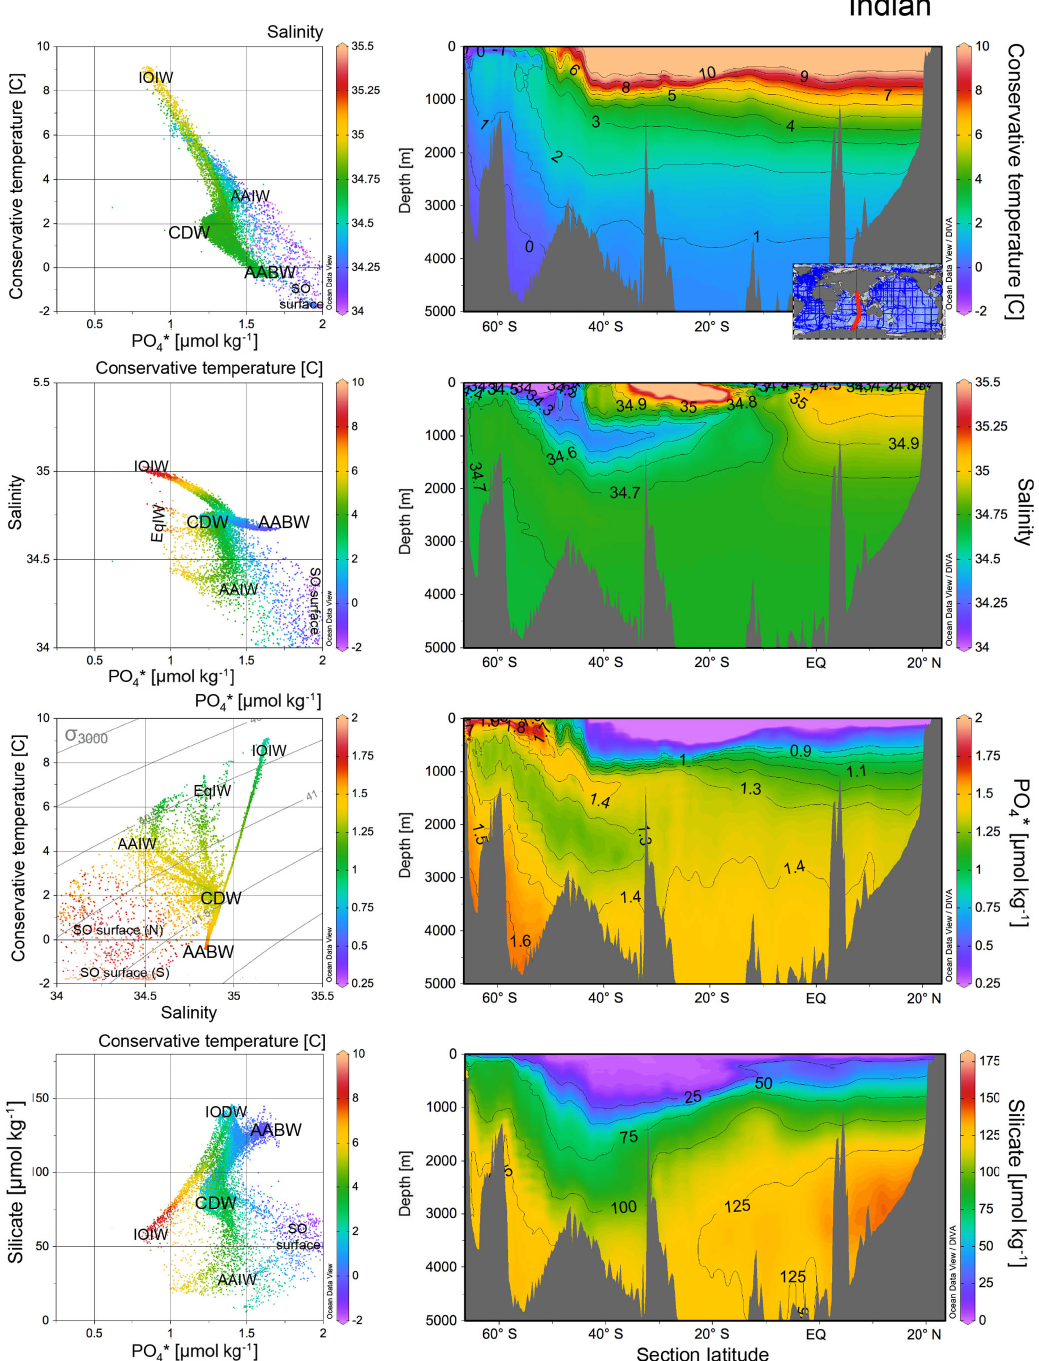
Figure A2. Indian Ocean hydrographic section for potential temperature, salinity, PO ∗ section with neutral density greater than 27.2kgm − 3 ; the colours of the dots refer to the scale shown to the right of the cross plots. Data are from GLODAPv2 (Key et al., 2015; Olsen et al., 2016) with profiles, maps, and sections plotted in ODV (Schlitzer, 2015), with sections contoured using isopycnic